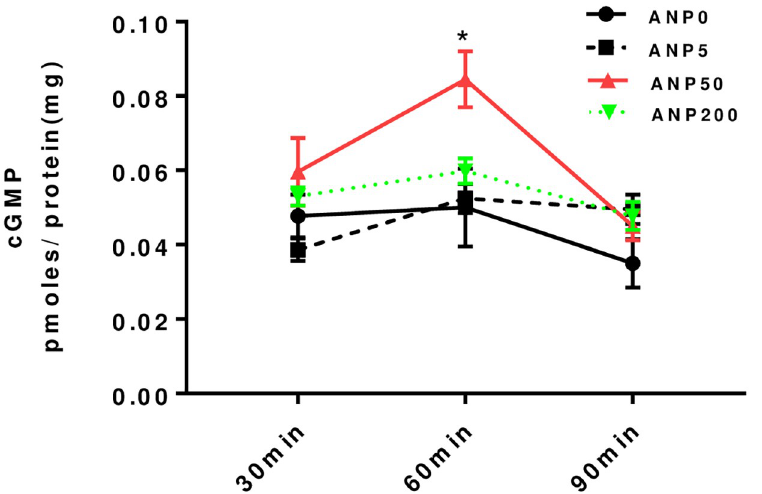
Fig 4. cGMP Levels. Intracellular cGMP levels following ANP treatment for 30, 60, and 90 min in H295R human adrenocortical cells. A significant increase in cGMP was observed only with 50 pg/mL at 60min. Error bars represent standard errors. ( � P < 0.05 compared to control; Y axis units are pM/mg protein).